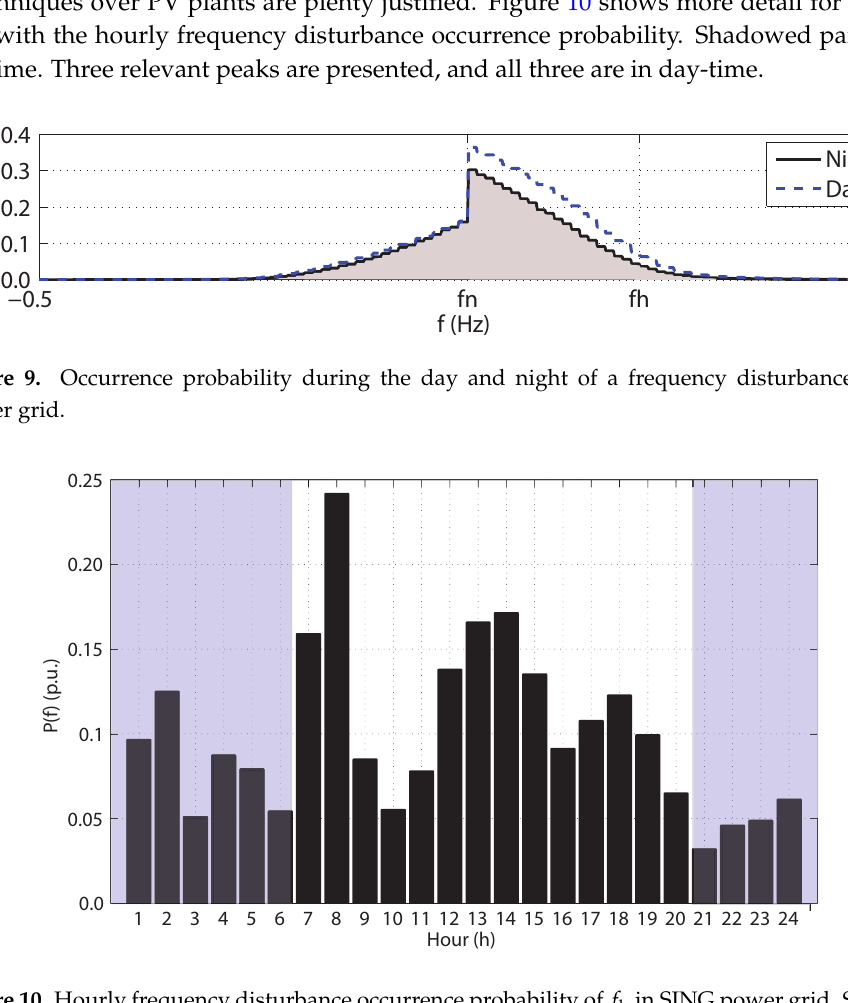
Figure 10. Hourly frequency disturbance occurrence probability of f h in SING power grid. Shadowed parts point out night